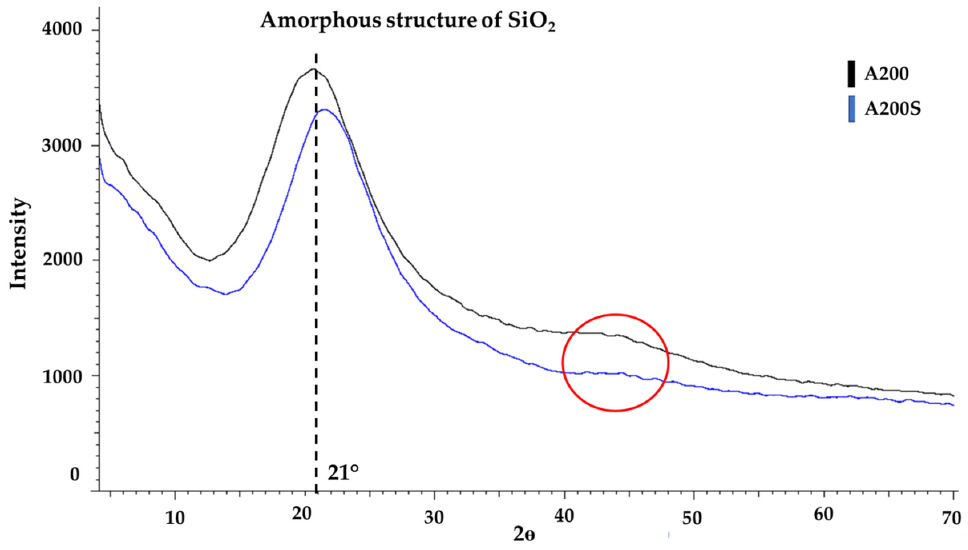
Figure 6. Di ff ractograms of A200 and A200S NPs. Figure 6. Diffractograms of A200 and A200S NPs. Figure 6. Diffractograms of A200 and A200S NPs.